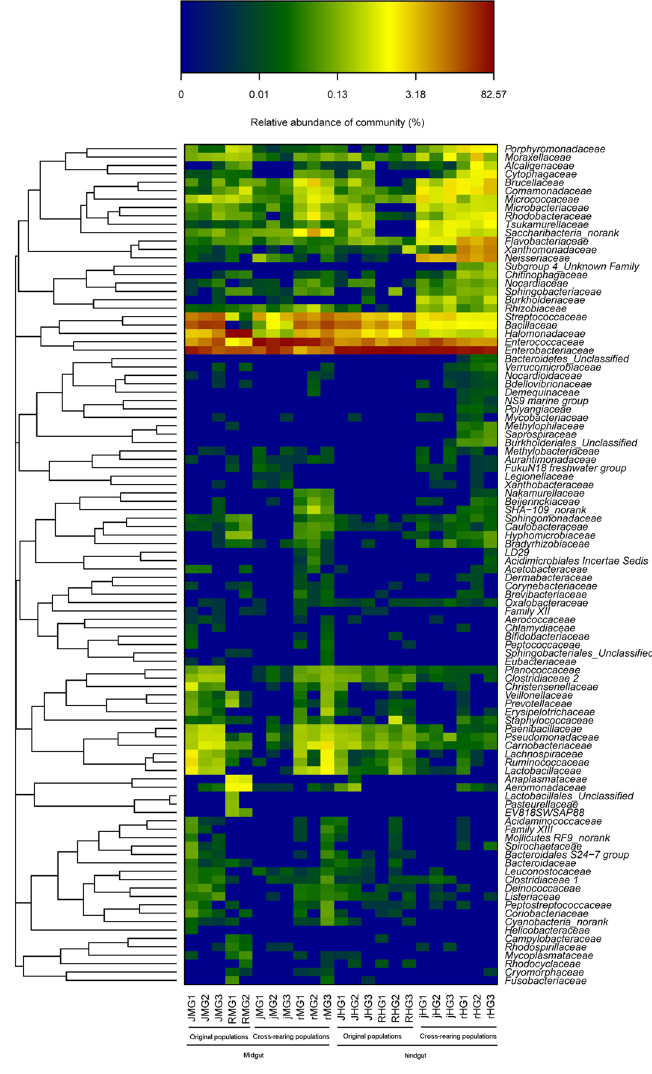
Figure 6. Abundance and composition of gut microbiota of all populations. Heatmap represent the proportions of OTUs at the family level. The X-coordinate represents the sample of each population, and the Y-coordinate represents the taxon. The color code indicates relative abundance, ranging from blue (low abundance) to yellow to red (high abundance). JMG1–JMG3 midguts of the water-oat population feeding on water-oat fruit pulps, RMG1–RMG2 midguts of rice population feeding on rice seedlings, jMG1–jMG3 midguts of the water-oat population feeding on rice seedlings, rMG1–rMG3 midguts of rice population feeding on water-oat fruit pulps, JHG1–JHG3 hindguts of the water-oat population feeding on water-oat fruit pulps, RHG1–RHG3 hindguts of rice population feeding on rice seedlings, jHG1–jHG3 hindguts of the water-oat population feeding on rice seedlings, rHG1–rHG3 hindguts of rice population feeding on water-oat fruit pulps; Original populations: C. suppressalis collected from water-oat field and reared on water-oat fruit pulps; or C. suppressalis collected from rice field and reared on rice seedlings. Cross-rearing populations: C. suppressalis collected from water-oat field but reared on rice seedlings; or C. suppressalis collected from rice field but reared on water-oat fruit